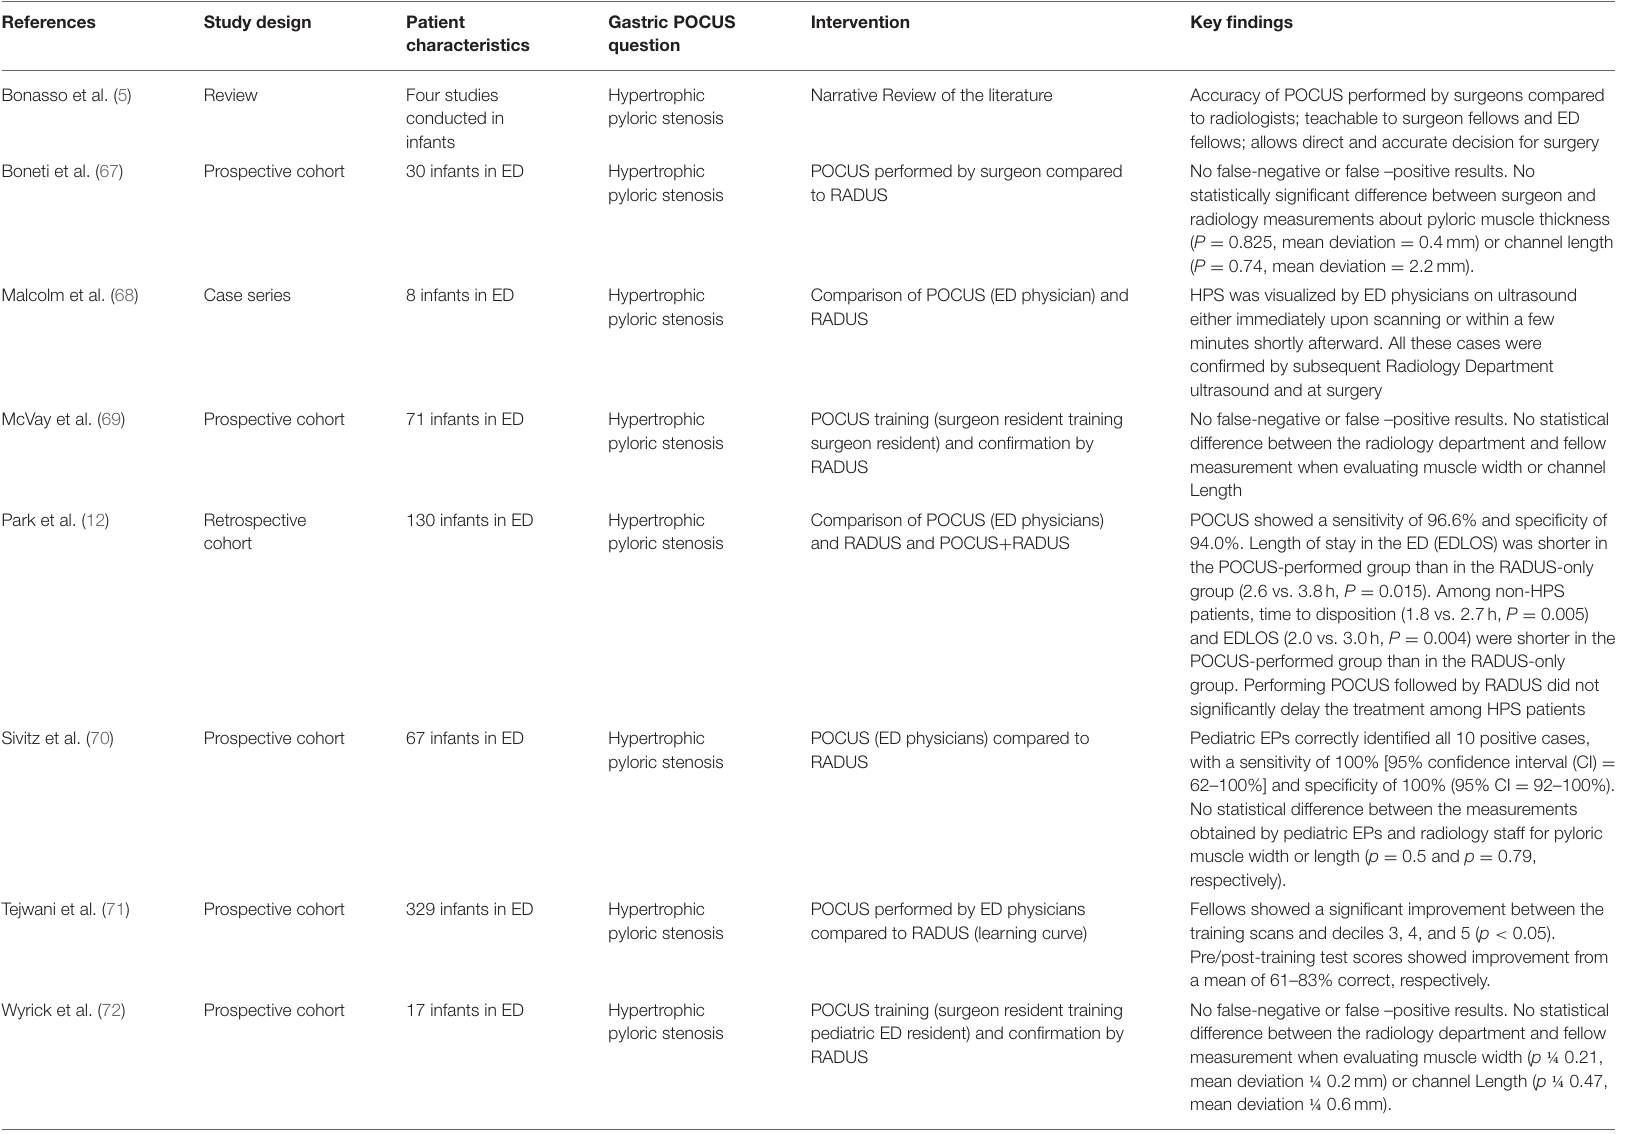
TABLE 4 | Study characteristics and findings: hypertrophic pyloric